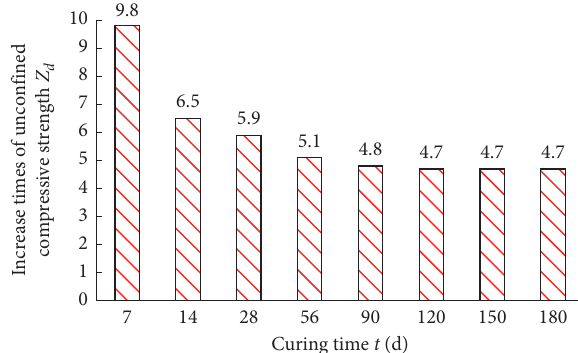
Figure 10: Multiple changes in the strength of the CMS with different cement contents during the curing